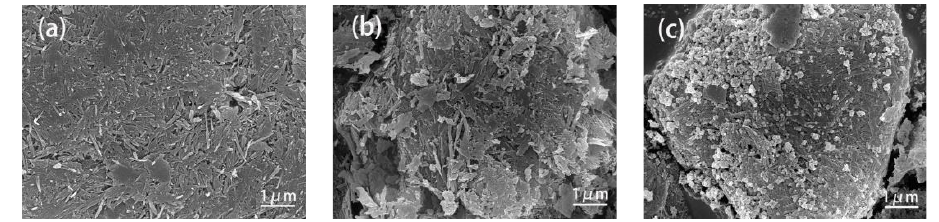
Figure 2. SEM image of Sep ( a ) and ABsep ( b ) and SEM-EDS image of HI/ABsep ( c ).